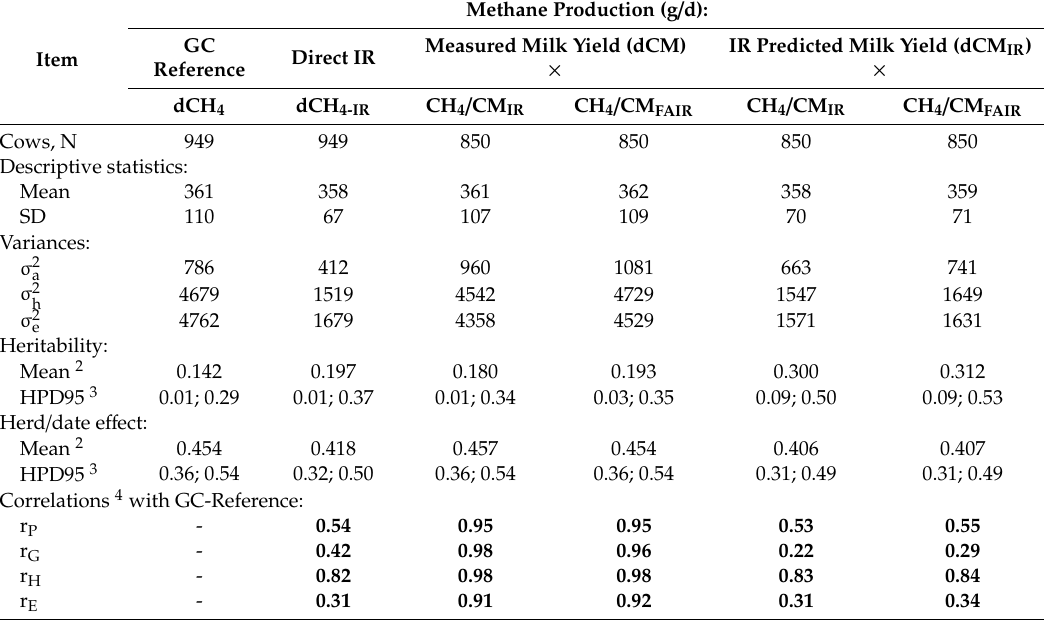
Table 4. Estimates of additive genetic ( σ 2 a ), herd / date ( σ 2 ), and residual ( σ 2 e ) variances, heritability, h and herd / date e ff ect of GC reference values based on GC FA profile, and of direct IR and indirect IR predictions 1 of daily methane production based on milk FTIR spectra; and additive genetic (r G ), herd (r H ), residual (r E ), and phenotypic (r P ) correlations between GC reference and IR predicted methane emission traits 1